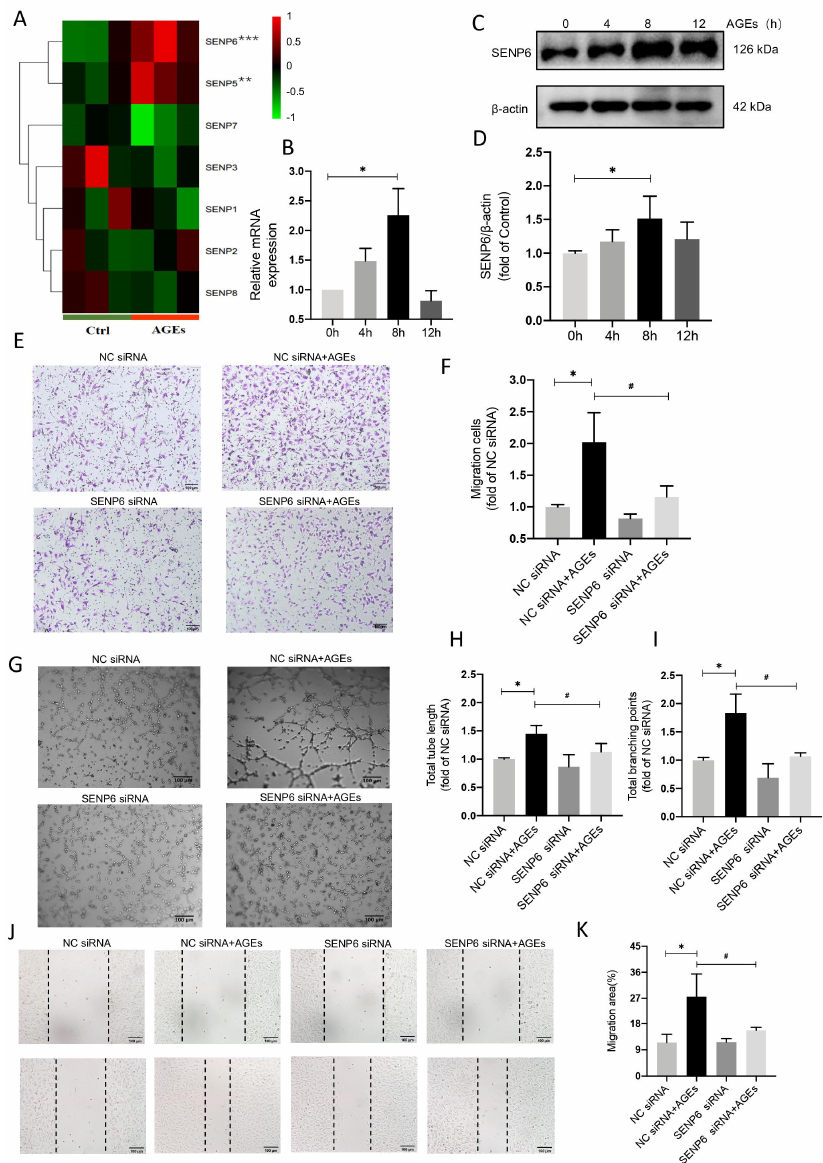
Figure 3. SENP6 − reduced HUVECs attenuate AGE − induced angiogenic signaling. ( A ) Heat map of mRNA showing the differences in SENPs expression between the control and AGEs groups. “Red” indicates up-regulation and “Green” indicates doregulation. ** indicates that p < 0.01 and *** indicates that p < 0.001 between the indicated groups. ( B ) Detection of SENP6 mRNA expression by qPCR at 0, 4, 8, and 12 h of AGE − stimulated HUVECs, n = 4, * p < 0.05 vs. 0 h. ( C ) The temporal effect of AGE stimulation on HUVECs was investigated using Western blot, which showed SENP6 protein expression at 0, 4, 8, and 12 h. ( D ) Analysis of protein expression level results, n = 6, * p < 0.05 vs. 0 h. AGE − induced angiogenic responses were inhibited by SENP6 silencing (Supplemental Figure S1C). HUVECs were transfected with NC siRNA or SENP6 siRNA for 48h. Cells were subjected to HUVECs migration and tube formation in response to AGEs. ( E ) Transwell migration assay for the migration ability. ( F ) Analysis of migration assay results, n = 3, * p < 0.05 vs. NC siRNA, # p < 0.05 vs. NC siRNA + AGEs, Scale bar: 100 µ m. ( G ) HUVECs tube formation in a Matrigel assay. Representative images are shown in ( G ). ( H , I ) Analysis of total tube length and total branching points results, n = 4, * p < 0.05 vs. NC siRNA, # p < 0.05 vs. NC siRNA + AGEs, Scale bar: 100 µ m ( J ) HUVECs migration by a scratch assay for indicated times. ( K ) Wound healing (% closure) was quantified, n = 5, * p < 0.05 vs. NC siRNA, # p < 0.05 vs. NC siRNA + AGEs, Scale bar: 100 µ m. * and # indicate significance between the indicated